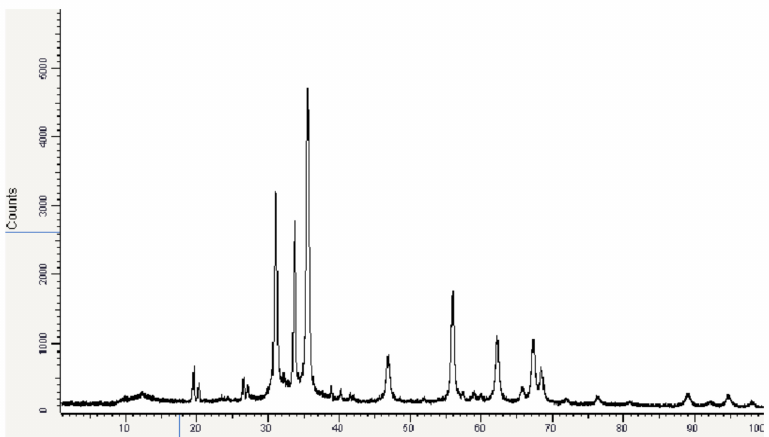
Figure 2. XRD pattern of ZnO